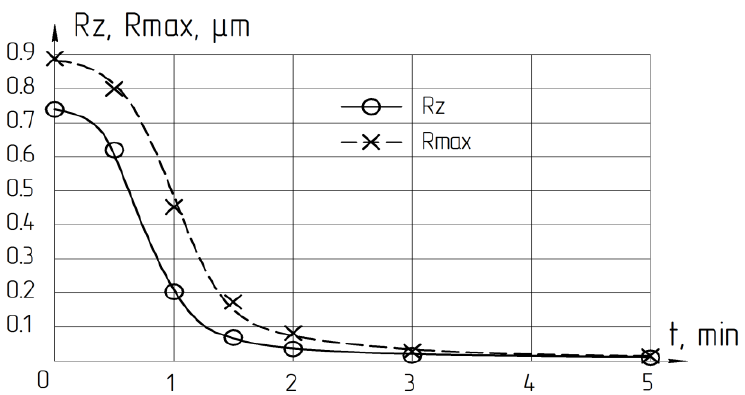
Figure 11. Polishing cycle time influence on the surface roughness of LNSC.